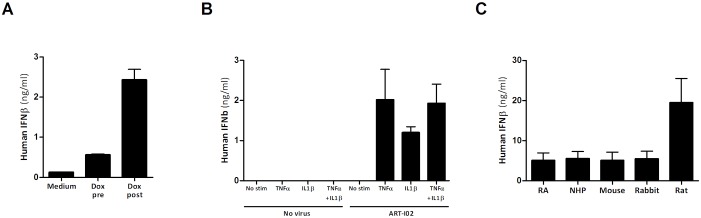
Human IFN-β expression levels in RA, rodent, rabbit and NHP FLS.Comparison of hIFN-β expression levels showed that DOX addition 4 hours post-transduction (‘Dox post’) improved expression in RA FLS more than 4-fold compared to DOX treatment 24 hours pre-transduction (‘Dox pre’) and almost 20-fold compared to medium only. In all three conditions, cells were stimulated with TNF-α (A). Transduction with ART-I02 resulted in increased levels of hIFN-β after stimulation of RA FLS. Without addition of ART-I02 or without stimulation (TNF-α and/or IL1-β), no hIFN-β was detected (B). Double stimulation with TNF-α and IL-1β did not increase the level of transgene expression compared to TNF-α stimulation alone (B). Human IFN-β production was detectable in culture supernatants of FLS of all species (C). For panel B and C, in all conditions doxorubicin was used. Data shown are mean + SEM, N = 2–3 experiments.